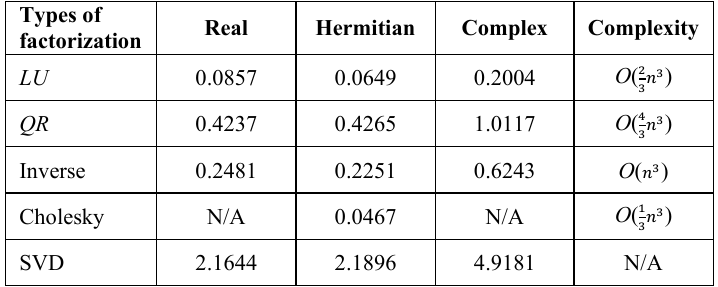
Table 2. Computation time (in second) when 𝑛 is 1500 .